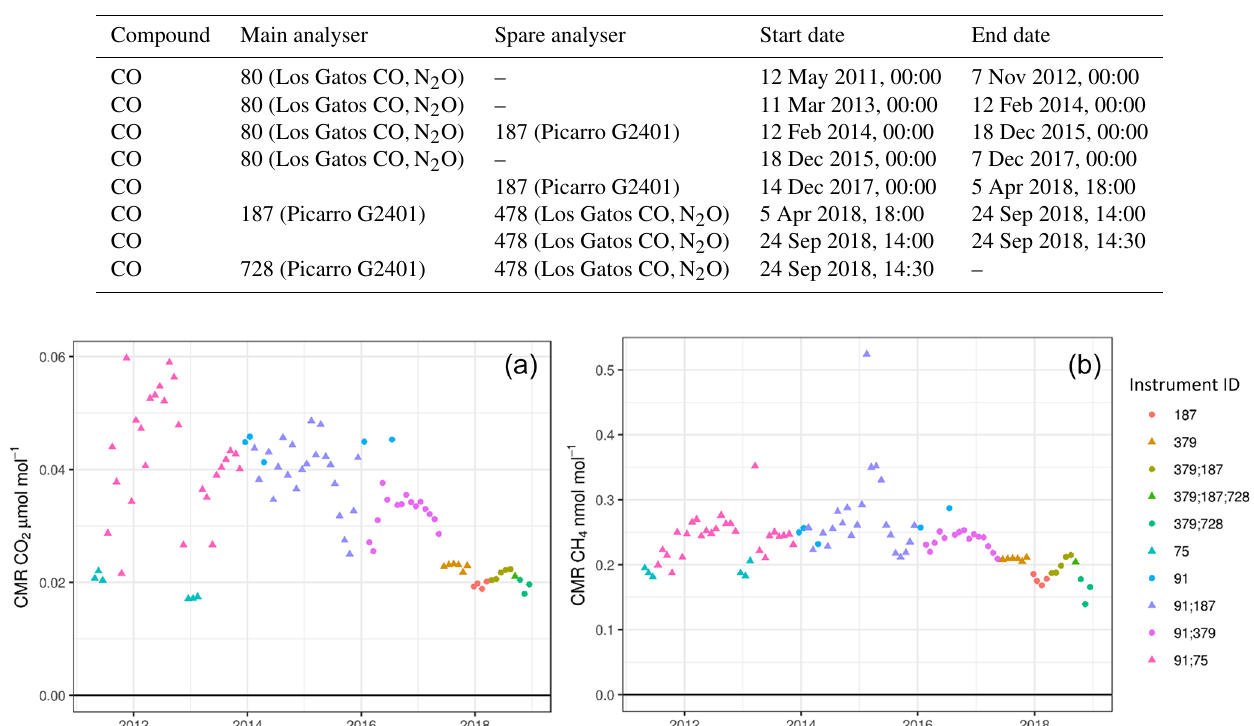
Table 3. Order of priority (main vs. spare analysers) for CO with ICOS instrument identifiers and associated period.